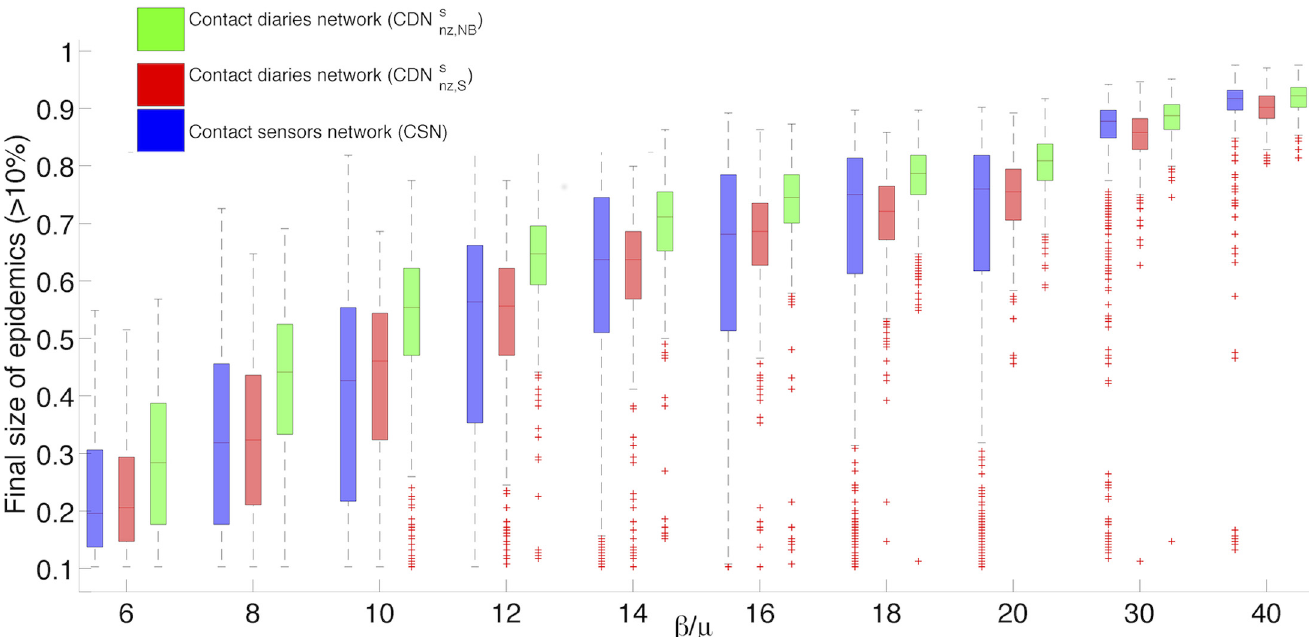
Fig 6. Box-plot of the distribution of epidemic sizes larger than 10%. Comparison of the distribution of epidemic sizes for SIR simulations performed on the contact sensors network (CSN), the surrogate contact network without zeros in the contact matrix of link densities and with weights randomly ), and the same surrogate contact network but with weights randomly drawn from the distribution of contact durations registered by sensors (CDN s nz ; S Þ . For each box, drawn from a negative binomial fi t of the distribution of contact durations registered by sensors in several similar environments (CDN s nz ; NB the central mark stands for the median, its edges represent the 25 th and 75 th percentiles. The whiskers extend to the most extreme data points not considered outliers, while outliers are plotted individually. Points are drawn as outliers if they are larger than a + h ( b − a ) or smaller than a − h ( b − a ), where a and b are the 25th and 75th percentiles, respectively and h is the maximum whisker length set by default to h = 1.5. (1000 simulations for each value of the ratio β / μ . β / μ 2 {6, 8, 10, 12, 14, 16, 18, 20, 30, 40}).